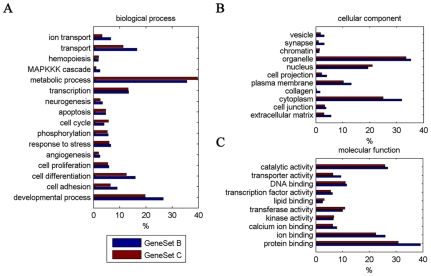
Functional annotation of the differentially expressed genes during the incomplete reprogramming of P19 cells.Gene Oncology analysis was performed to identify functional categories overrepresented in the cluster of genes of GeneSet B and C. (A) Gene Oncology analysis of Group B and Group C according to biological process. (B) Gene Oncology analysis of Group B and Group C according to cell component. (C) Gene Oncology analysis of Group B and Group C according to molecular function. The blue column represents Group B; the red column represents Group C. The X-axis represents the percentage of each sub-category in this category. The Y-axis represents a detailed description of the roles of each sub-category. p-value<0.05.